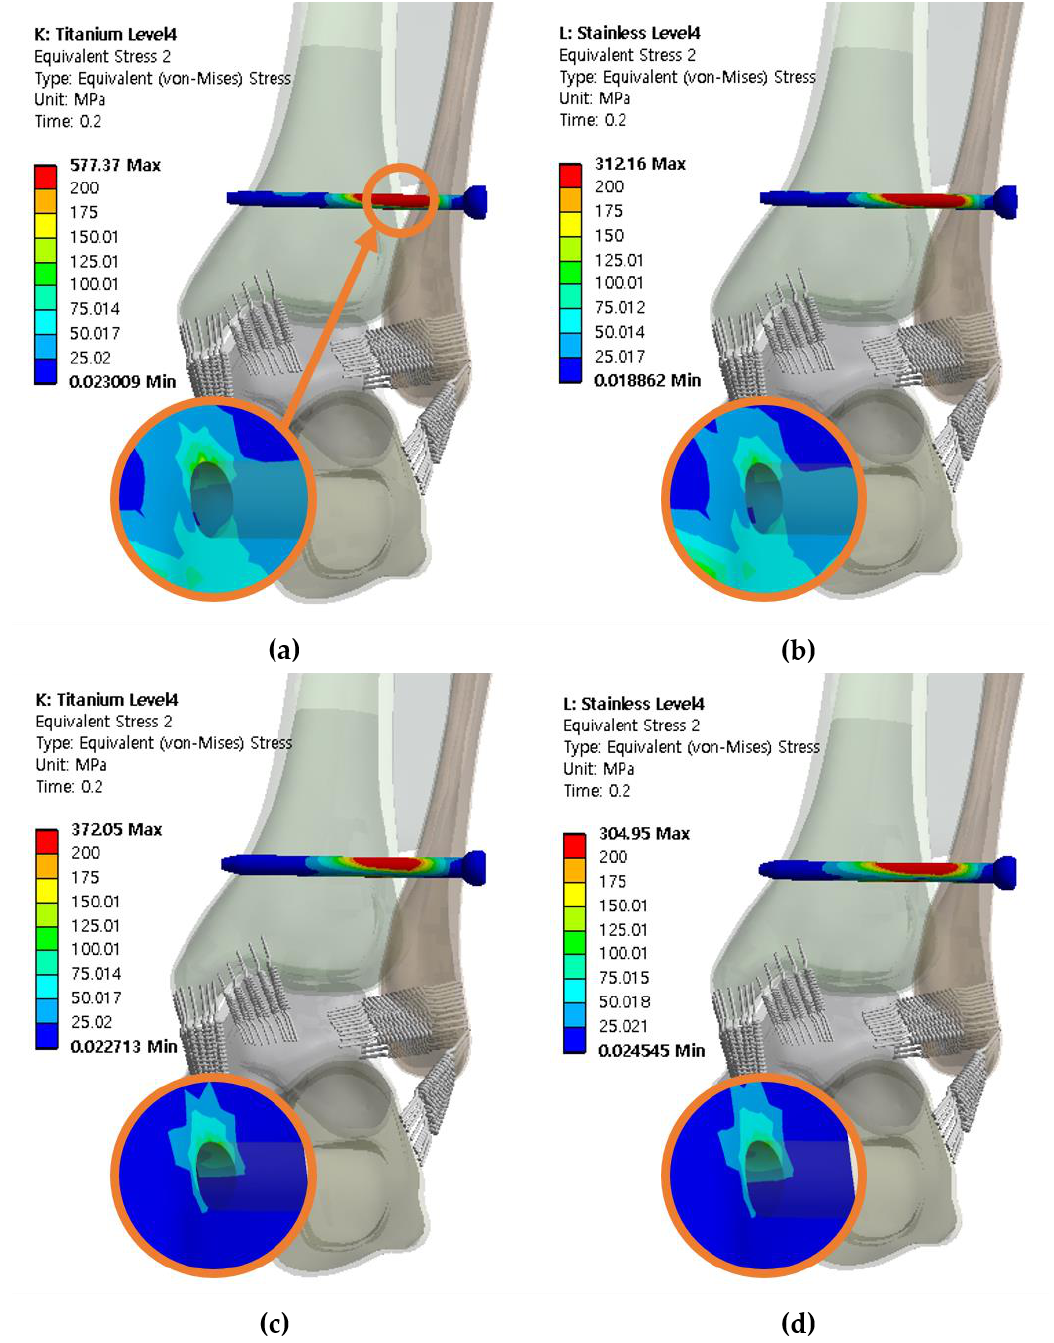
Figure 5. The von Mises stresses of the syndesmotic screw and adjacent bone at screw level of 25 mm with four cortical bones purchased: ( a ) titanium screw with a diameter of 3.5 mm, ( b ) stainless steel with a diameter of 3.5 mm, ( c ) titanium screw with a diameter of 4.5 mm, and ( d ) stainless steel screw with a diameter of 4.5 mm. Table 5. Maximum von Mises stresses and syndesmosis widening: titanium screw with three cortical bones purchased.